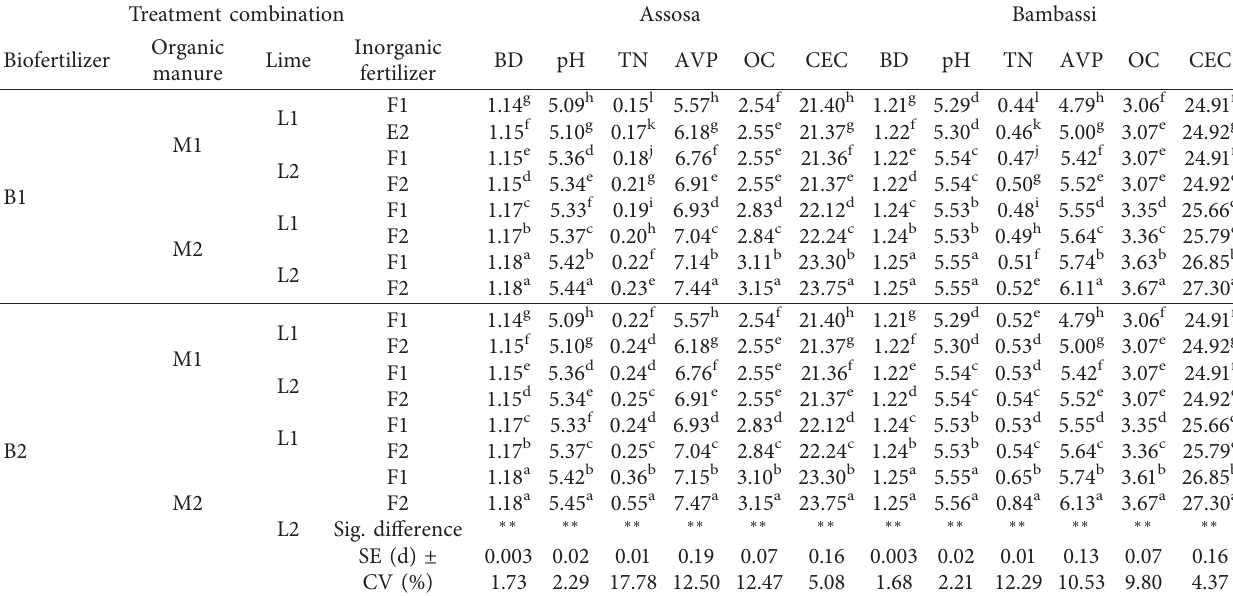
Table 5: Interaction effects of biofertilizer, organic manure, inorganic NPSB fertilizer, and lime on soil physicochemical properties after two years of experiment at both locations in Assosa Zone, Western